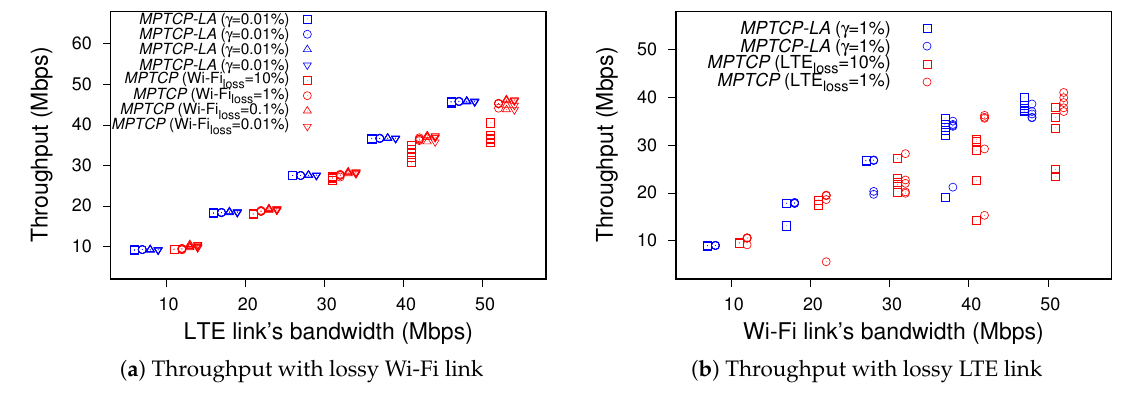
Figure 4. Throughput comparison between the default MPTCP and